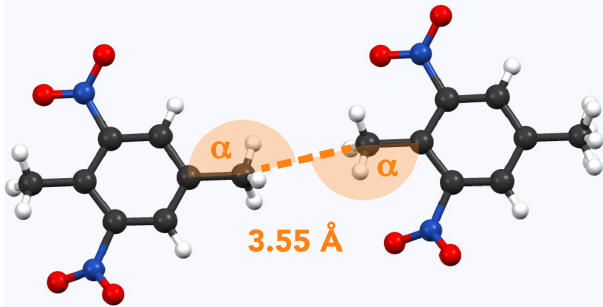
Figure 5. Example of methyl pairs in the crystal structure of 8 (AY- OYAP; Johnston and Crather, 2011). The distance between them is 3.55Å (measured carbon to carbon). Respective angles (measured carbon to carbon to carbon) are α = 168 ◦ .